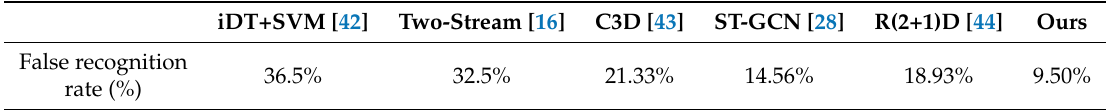
Table 5. The results of field tests in real